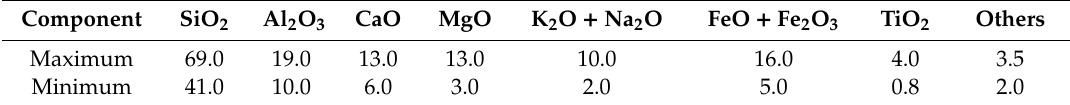
Table 1. The chemical compositions of basalt (wt.%)